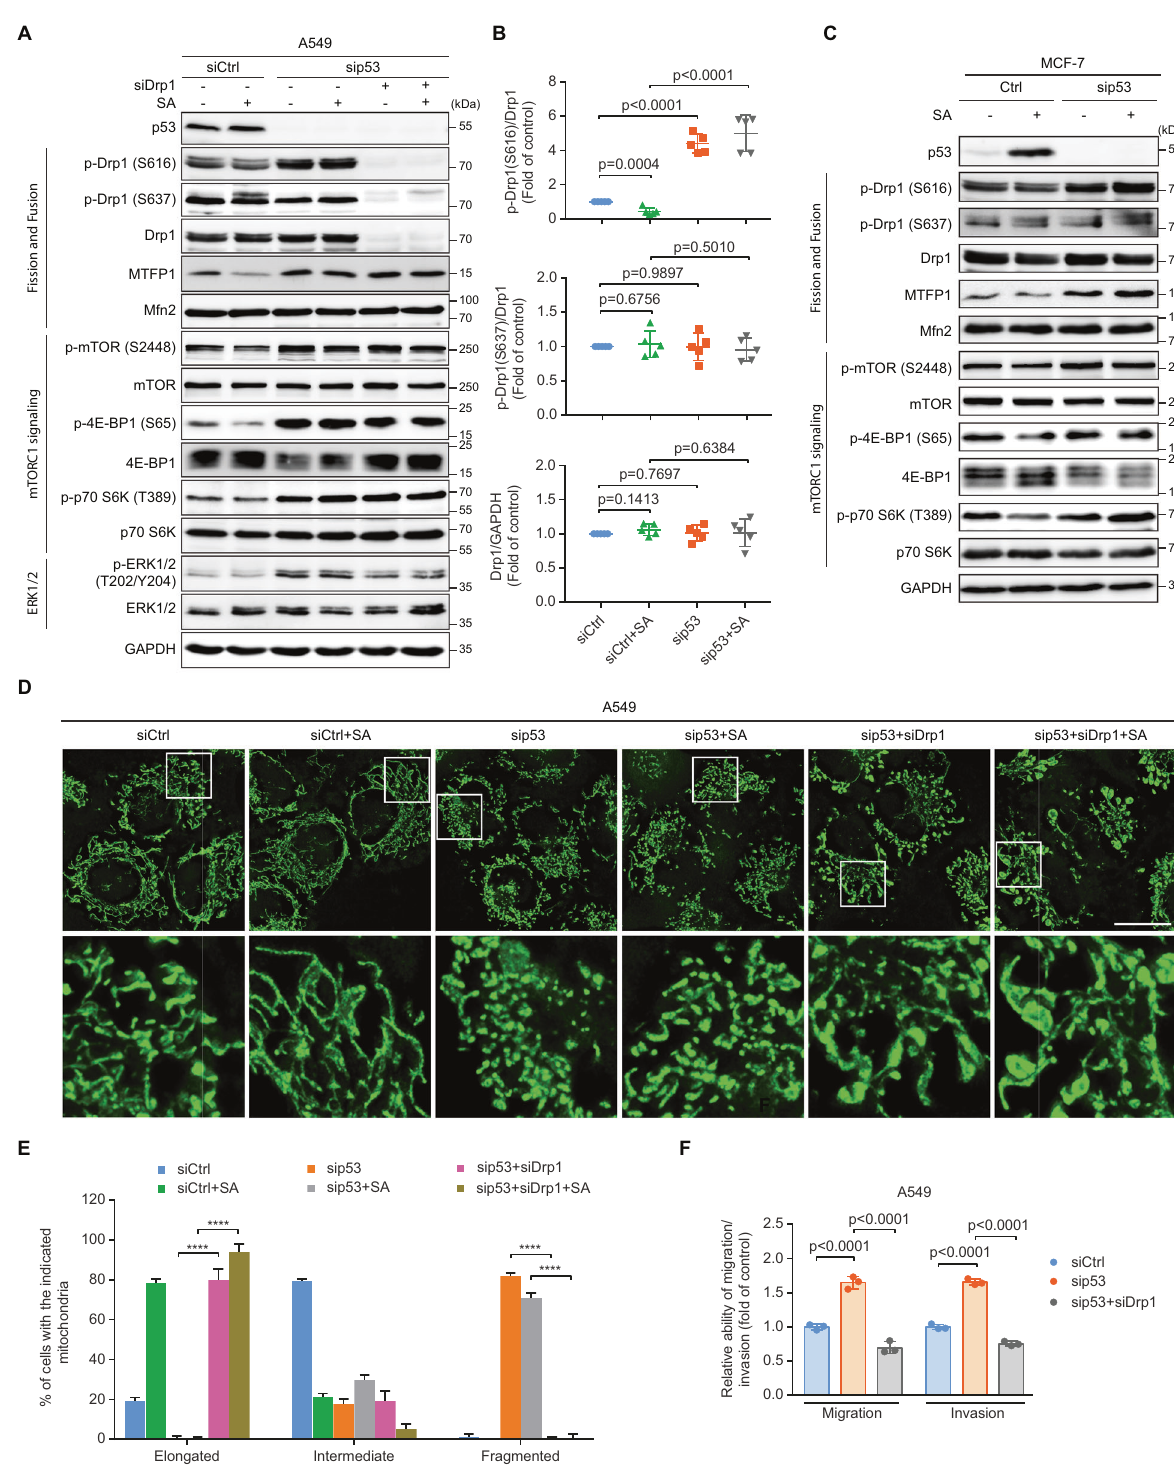
Fig. 4 p53 alleviates Drp1-mediated mitochondrial fi ssion and thereby restrains cell migration and invasion. A Immunoblot of the indicated proteins in siCtrl, sip53, and p53/Drp1 double-knockdown (sip53 + siDrp1) A549 cells with and without 20 µM SA treatment for 24 h. GAPDH was used as a loading control. B Quanti fi cation of levels of Drp1, p-Drp1 (S637), and p-Drp1 (S616) in Fig. 4 A. C Immunoblot of the indicated proteins in siCtrl and sip53 MCF-7 cells with and without 20 µM SA treatment for 24 h. GAPDH was used as a loading control. Representative images ( D ) and quanti fi cation ( E ) of mitochondrial morphology in siCtrl ( n = 226), siCtrl + SA ( n = 232), sip53 ( n = 205), sip53 + SA ( n = 214), sip53 + siDrp1 ( n = 230), and sip53 + siDrp1 + SA ( n = 214) A549 cells. Boxed regions in ( D ) are shown enlarged in the bottom panels. Scale bar: 20 µm. F Transwell assays for siCtrl, sip53, and sip53 + siDrp1 A549 cells. Error bars represent mean ± SD. Data were analyzed by two-tailed unpaired Student ’ s t test ( B ) or one-way ANOVA with Tukey ’ s multiple comparisons test ( E and F ). ****p <